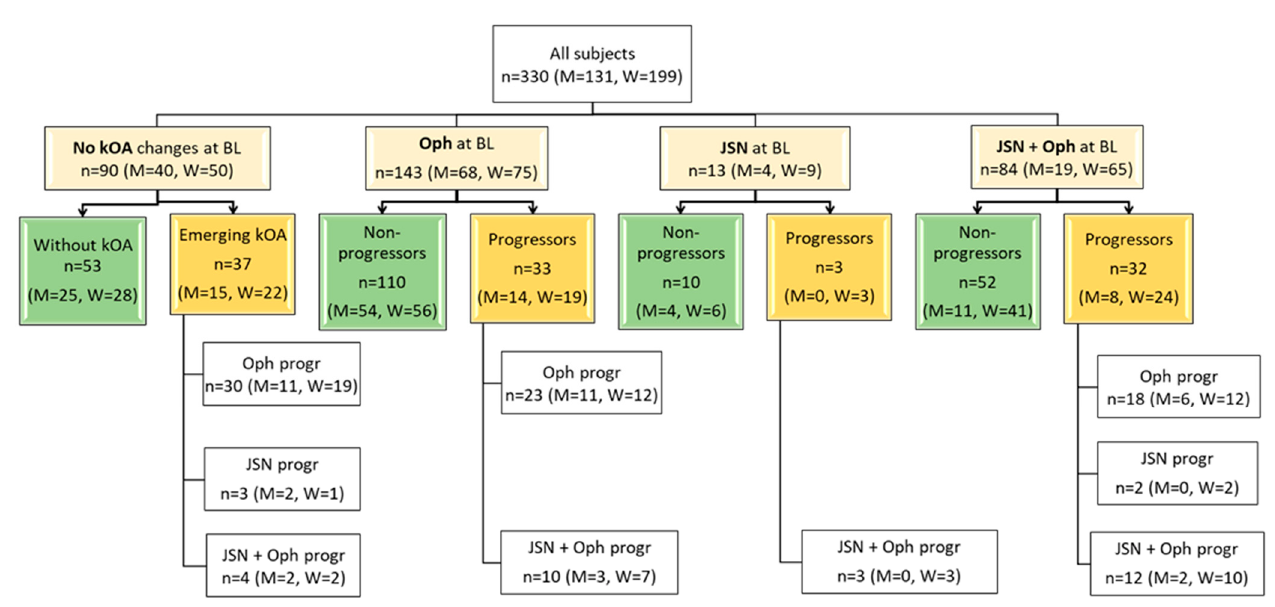
Figure 1. Baseline/initial (T0) radiographic status of the knees of the cohort and type of progression 3 years later (T1). BL, baseline; Oph, osteophytes; JSN, joint space narrowing; Oph + JSN, osteophytes and joint space narrowing at the same time; Progressors—subjects with the progression of knee osteoarthritis (kOA) during 3 years; Non-progressors—subjects without radiographical changes of kOA during 3 years; Oph progr—radiographic progression of osteophytes; JSN progr— radiographic progression of joint space narrowing; Oph+JSN progr—radiographic progression of osteophytes and joint space narrowing; n, numbers, M, numbers in men, W, numbers in women.